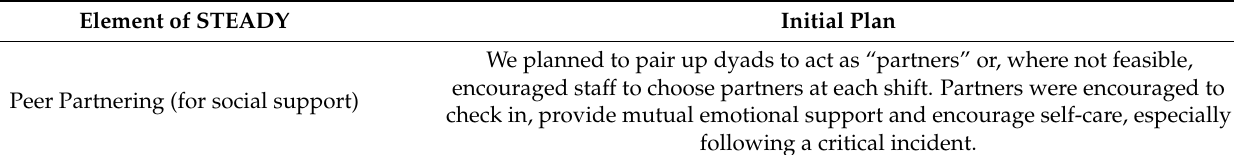
Table 1. Initial adaptation of STEADY elements planned for target “STEADY units”. Element of